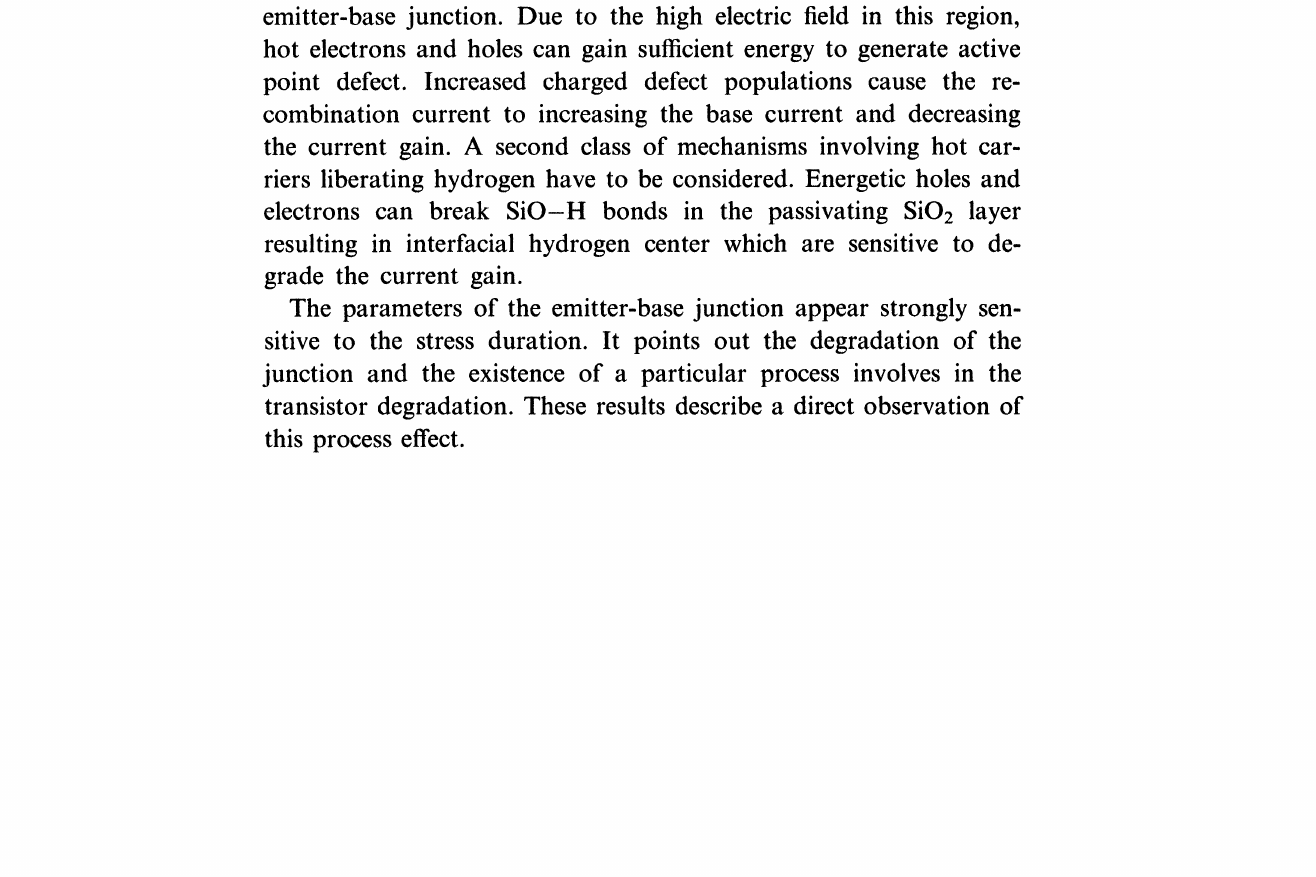
FIGURE 8 emitter open.